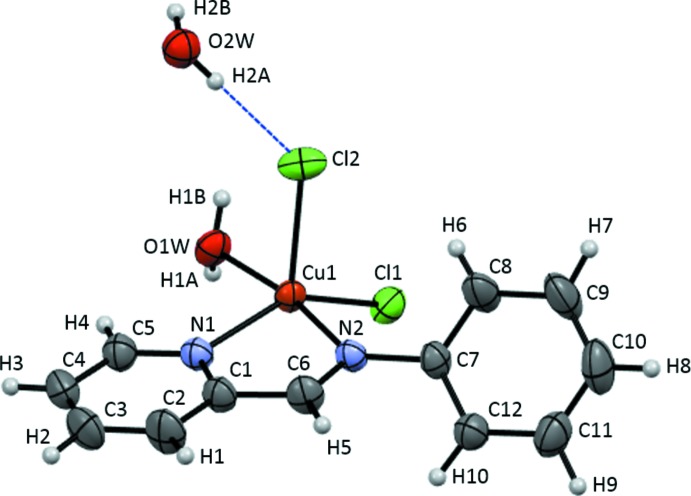

ORTEP representation of the title complex with the atom numbering. Displacement ellipsoids are drawn at 50% probability level. The hydrogen bond to the water mol­ecule of crystallization is shown as a dashed blue line.